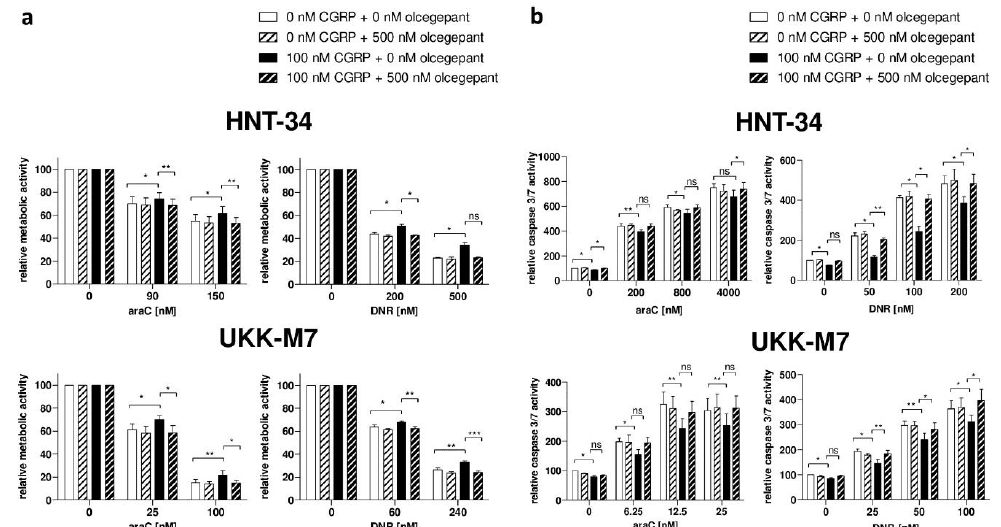
Figure 5. Olcegepant counteracts the CGRP-induced increase in chemotherapy resistance. HNT-34 and UKK-M7 cells were pre-incubated first with 500 nM olcegepant or an equivalent amount of solvent for 15 minutes, next with or without 100 nM CGRP for 1 h, prior to addition of the indicated concentrations of araC or daunorubicin (DNR). Means + SEM from 3–5 biological replicates. ns, not significant, * p < 0.05, ** p < 0.01, *** p < 0.001, paired Student's two-tailed t-test. ( a ) CellTiter-Glo metabolic activity assay. ( b ) Caspase 3/7 assay.